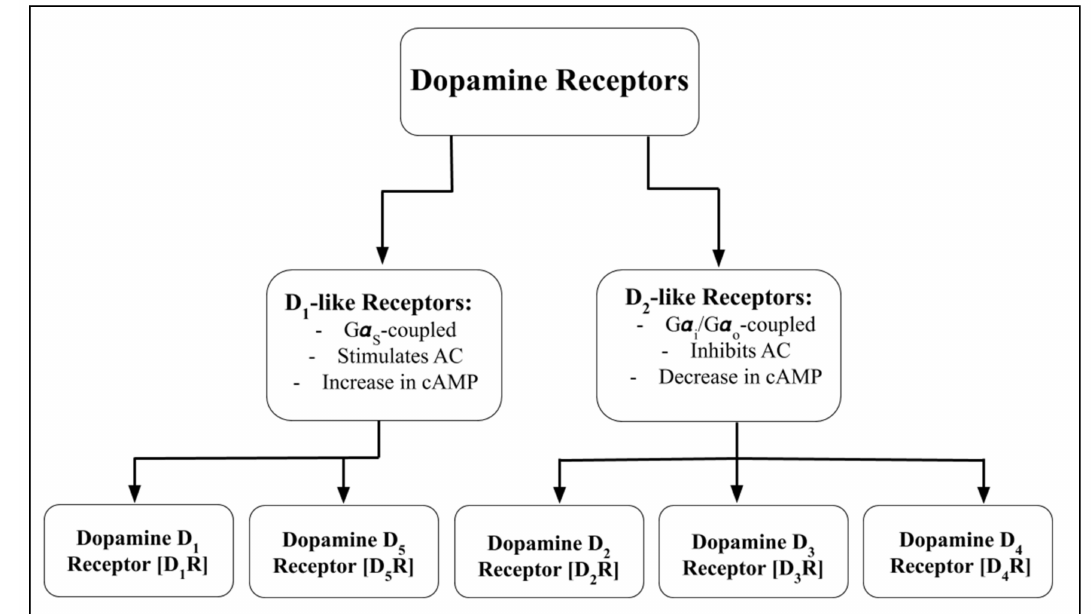
Figure 1. Schematic diagram summarizing dopamine receptor subtypes. G α S , G S alpha subunit; G α i /G α o , G i alpha subunit/G o alpha subunit; AC, Adenylyl Cyclase; cAMP, Cyclic Adenosine Monophosphate.